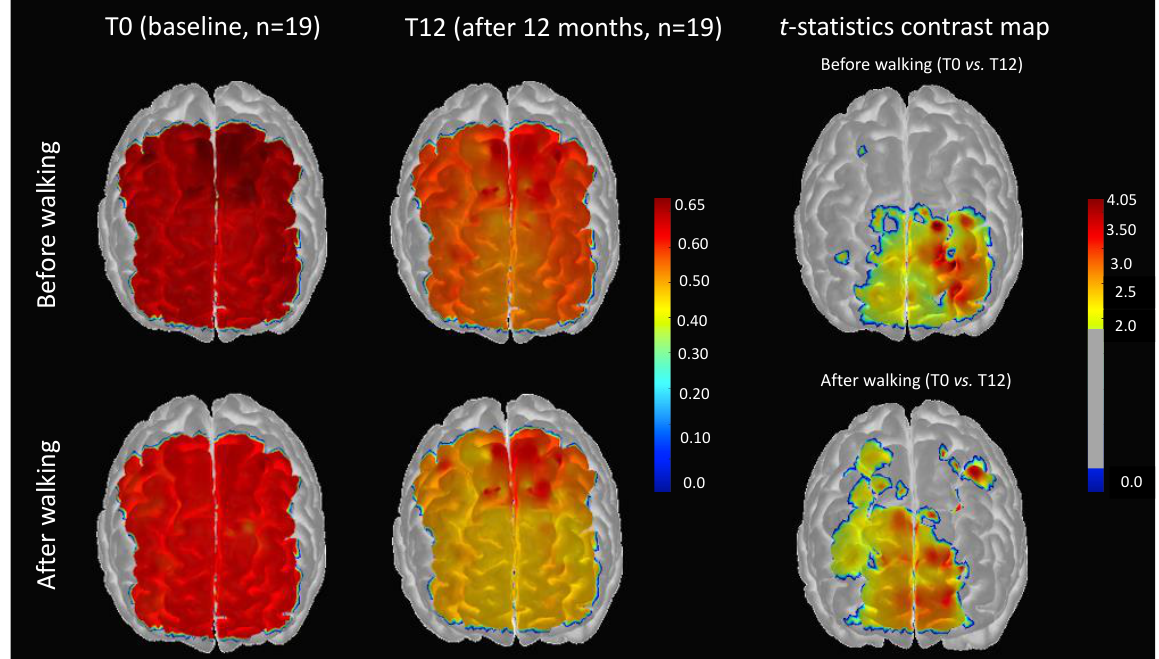
Figure 3. ( Left ) Channel-wise spatial distribution of the cerebral pulse amplitude projected on the cortex Colin27 template at baseline (T0) and after 12 months of physical activity (T12). ( Right ) t -statistics topographic contrast maps for the channel-wise comparison of cerebral pulse amplitude. These maps are thresholded and are FDR-corrected ( p < 0.05).